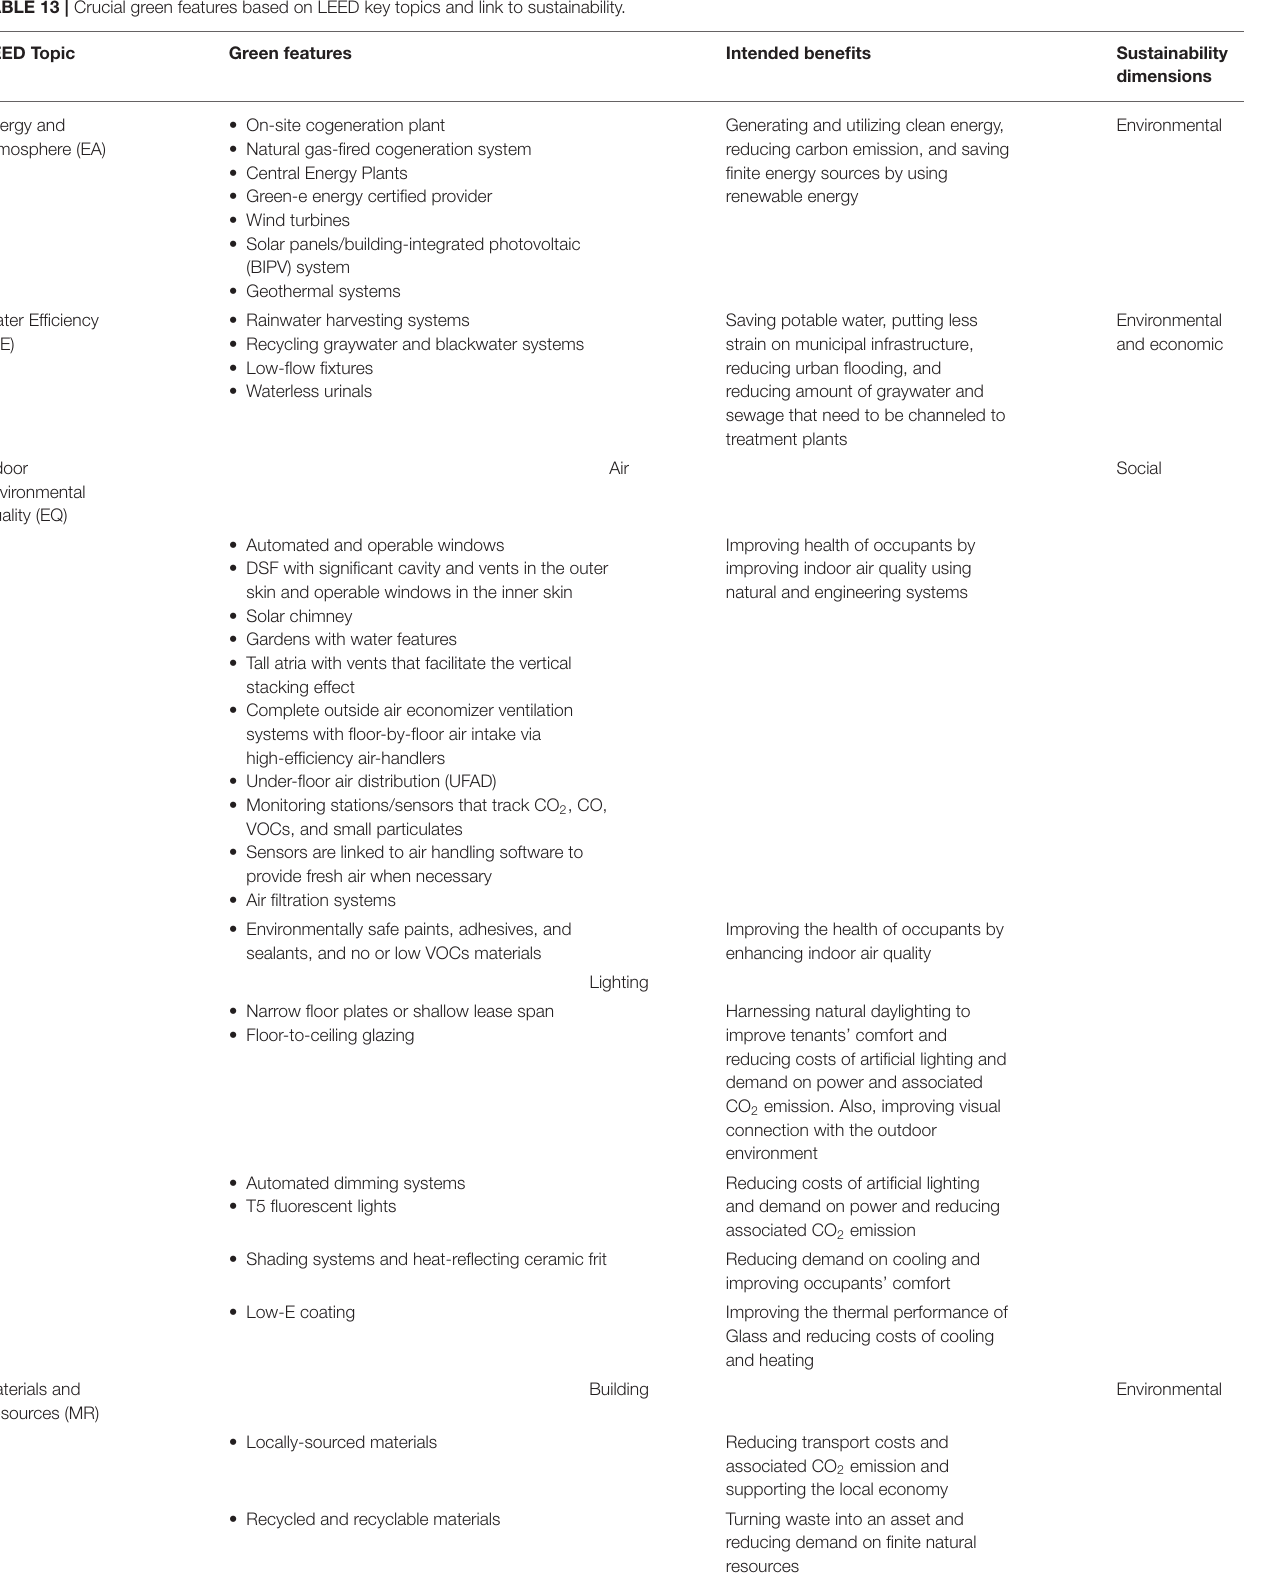
TABLE 13 | Crucial green features based on LEED key topics and link to sustainability. LEED